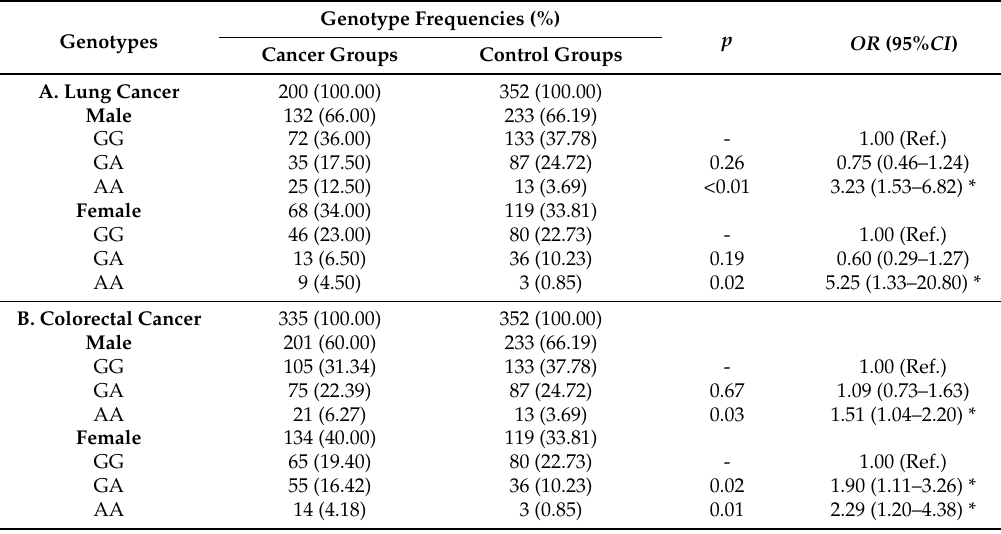
Table 6. Analysis for sex difference in LOX G473A genotype frequency